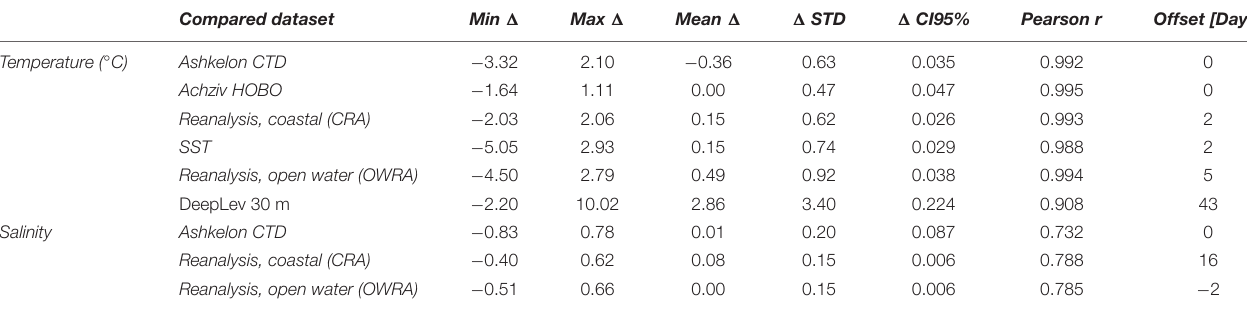
TABLE 2 | Summary values for temperature and salinity contemporaneous datasets compared with Hadera station time series. Compared dataset